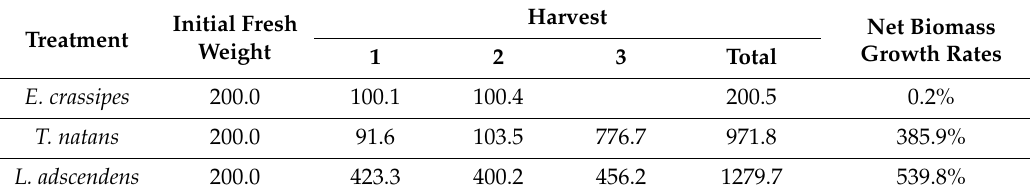
Figure 4. Growth status of E. crassipes in two types of eutrophic water bodies: ( a ) to ( c ): the roots and leaves turned white and rotted gradually (in the swine manure wastewater); and ( d ) to ( e ) the roots were purple and grew vigorously (in the river). Table 1. Biomasses of floating aquatic macrophytes after 60 days of treatment in swine manure wastewater (g / pot, fresh